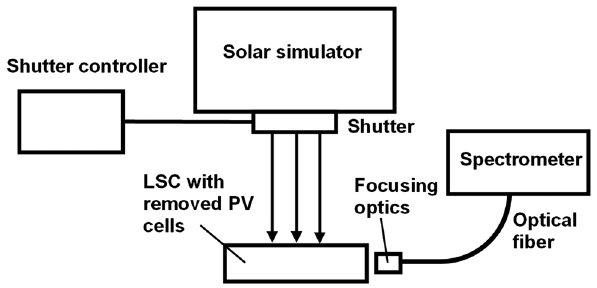
Figure 10: Block diagram of the experimental setup to investigate the spectrum scattered by the LSC to the edge - attached PV